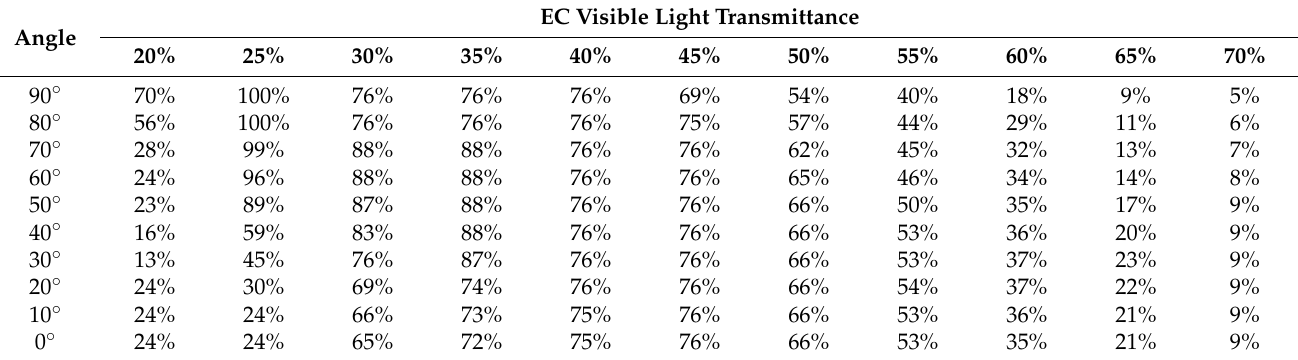
Table 6. Target illuminance achievement rates when the number of divisions of louvers is 12.